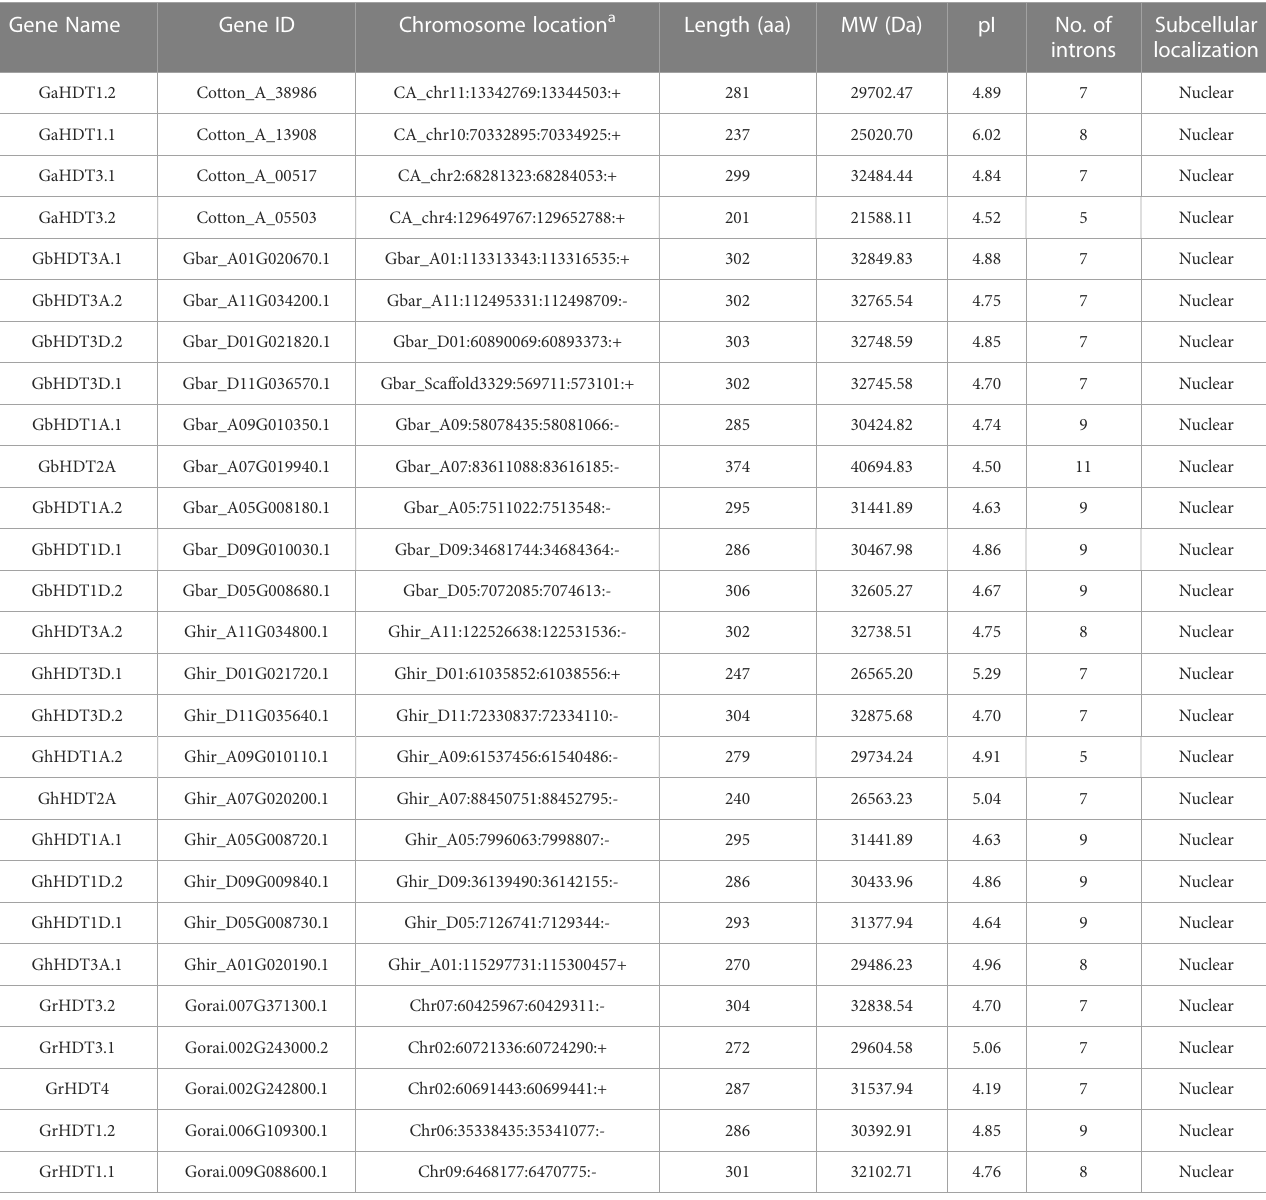
TABLE 1 HD2 genes in G. arboreum, G. raimondii, G. hirsutum , and G. barbadense , and their